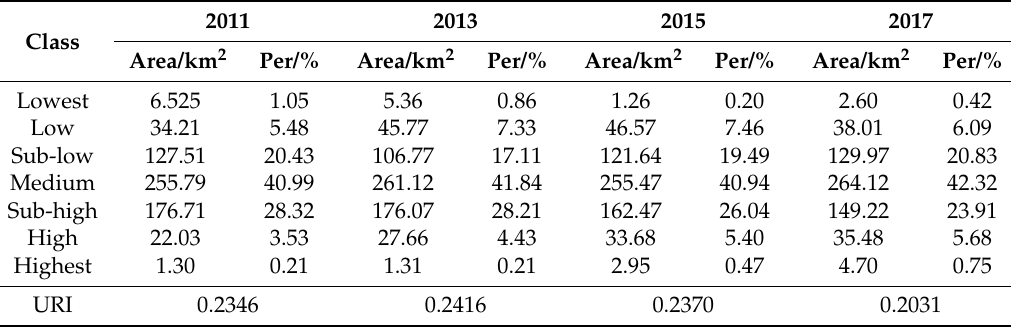
Figure 6. Spatiotemporal patterns of LST in the core urban areas of GF on 22 September 2011, 11 October 2013, 18 October 2015 and 23 October 2017. (LST_AVG: average LST; LST_SD: LST standard deviation). Table 3. Variation of graded area of LST in the core areas of GF.